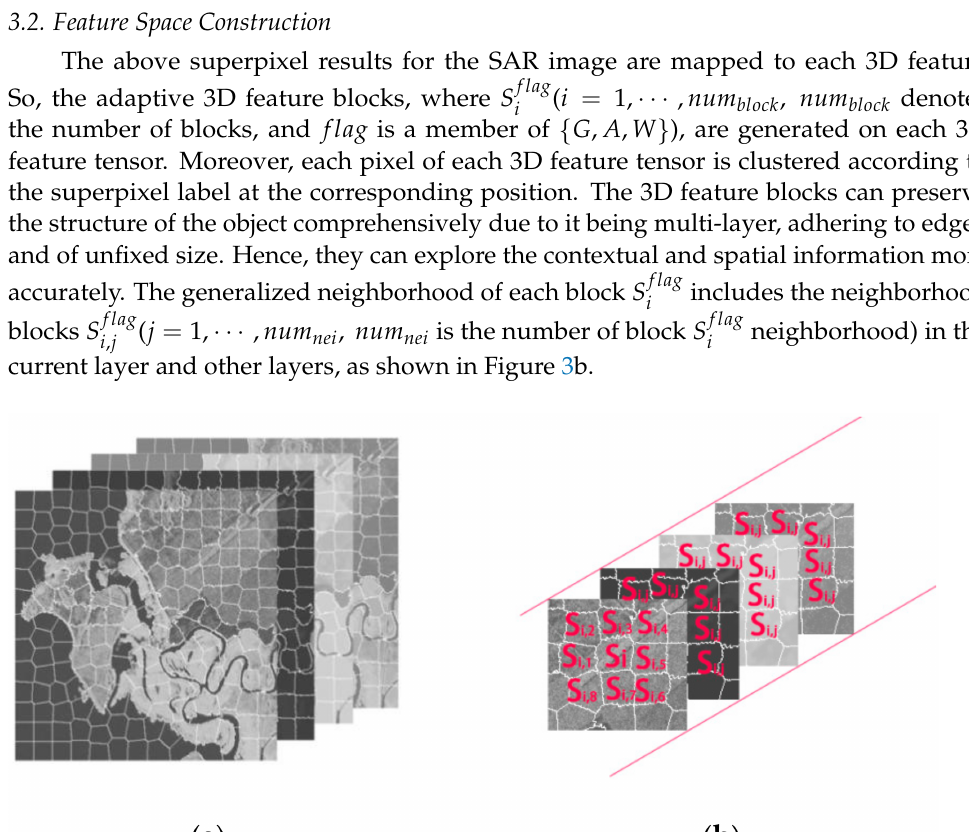
Figure 2. Comparison of superpixel results: ( a ) the improved algorithm, ( b ) the previous algorithm, ( c ) the zoom part of ( a ), and ( d ) the zoom part of ( b ).